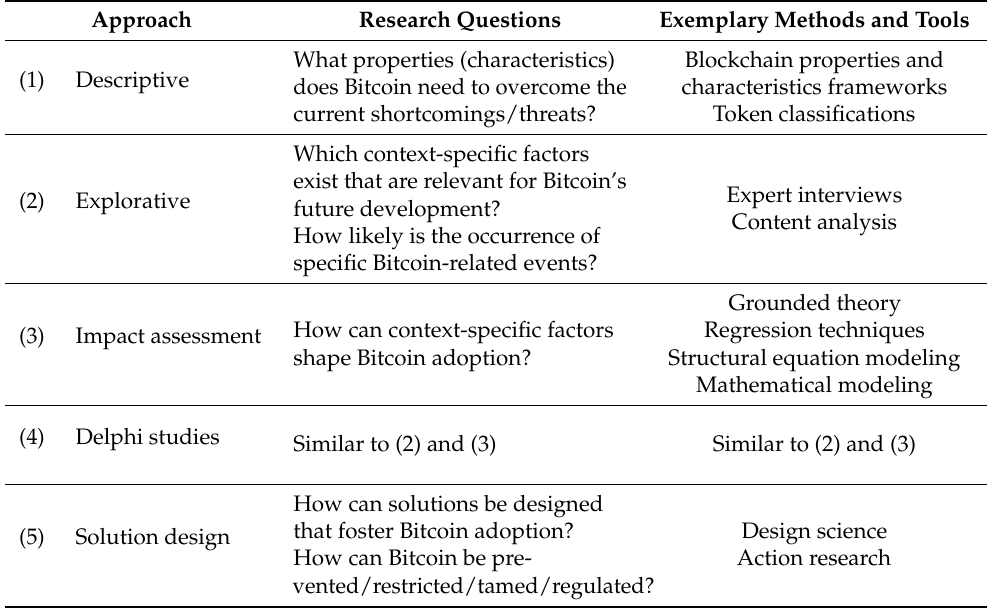
Table 3. Research questions for future Bitcoin research based on